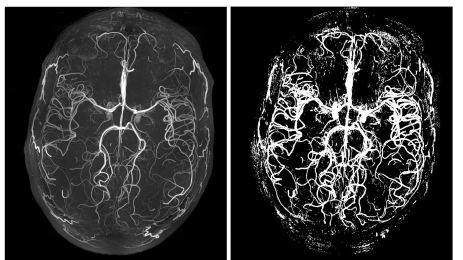
Figure 3. Maximum intensity projection (MIP) of the actual volume and the segmentation labels created using